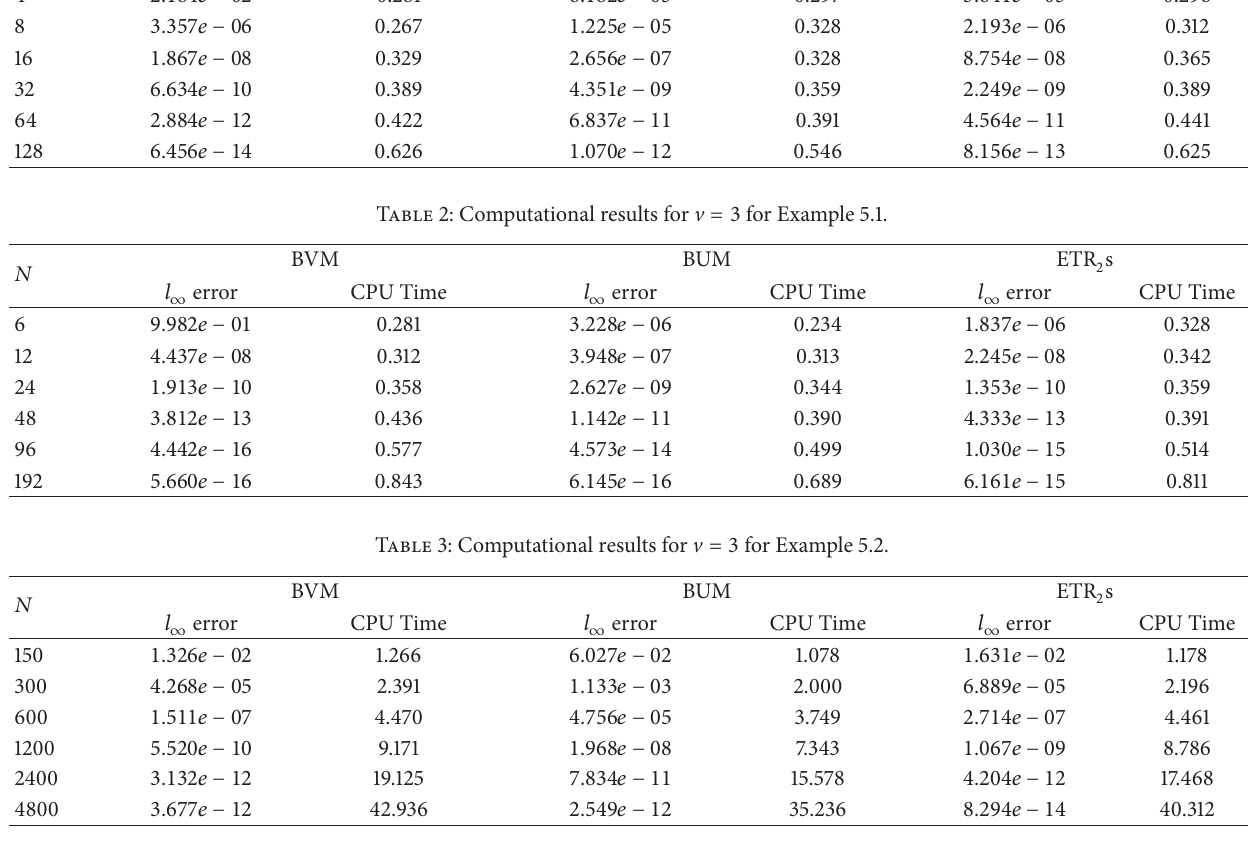
Table 4: Computational results for V = 4 for Example